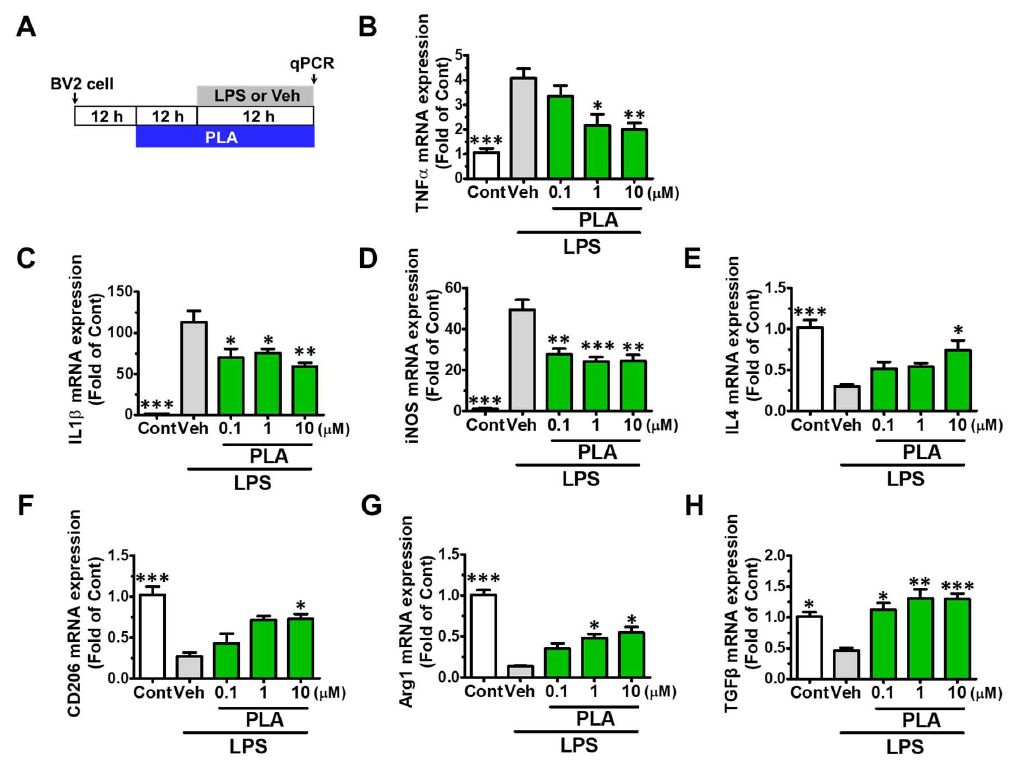
Figure 2. Effects of platycodigenin (PLA) on LPS-induced mRNA expression of M1/M2 microglia Figure 2. E ff ects of platycodigenin (PLA) on LPS-induced mRNA expression of M1 / M2 microglia markers. BV2 microglia were cultured for 12 h and pretreated with PLA (1 and 10 µ M) or control